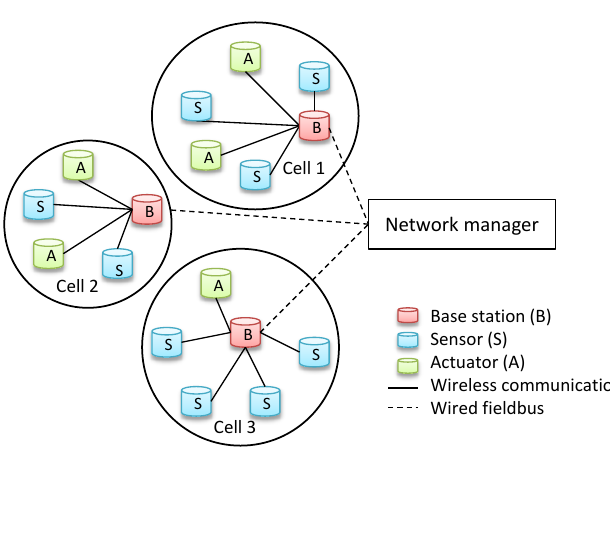
Figure 2. WISA network